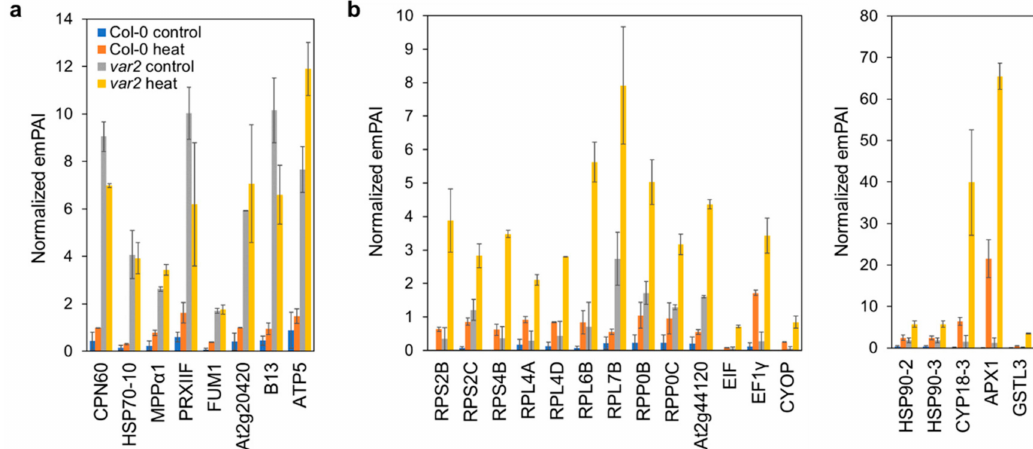
Figure 5. Consequences on mitochondria and cytosolic proteostasis. All the bar graphs indicate normalized emPAI-based quantitative values (the mean of the two replicates +/ − SD). For further information, see Table S1. ( a ) Mitochondrial proteins affected by proteotoxic stresses occurring on the thylakoids. The affected proteins were chaperones (CPN60, HSP70- 10), peptidase (MPP α 1), peroxiredoxin (PRXIIF), fumarate hydratase (FUM1), succinate-CoA ligase subunit (At2g20420), NADH dehydrogenase (Complex I) subunit (B13) and ATP synthase (Complex V) subunit (ATP5) in mitochondria. ( b ) Cytosolic proteins deposited in response to the proteotoxicity invoked by heat and FtsH loss. Left panel shows 80S ribosome subunit proteins (RPS2B/2C/4B, RPL4A/4D/6B/7B/RPP0B/0C and At2g44120), translation factors (EIF and EF1 γ ) and oligopeptidase (CYOP). Proteins related to protein folding (HSP90-2/3 and CYP18-3) and ROS-detoxification (APX1 and GSTL3) are in the right